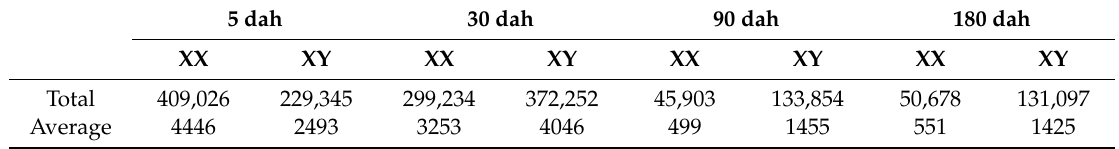
Figure 5. A heat map showing tissue distribution (RPKM: reads per kb per million reads) of RP genes in eight tissues based on transcriptome data in tilapia. Red and blue indicate high and low expression, respectively. Each row represents a different gene, and each column represents an independent tissue sample. The widespread complex expression patterns in all tissues were readily discernable. Most of the RP genes displayed high and ubiquitous expression in all tissues examined. Table 2. Statistics of RP gene expressions in tilapia gonads at four developmental stages. 5